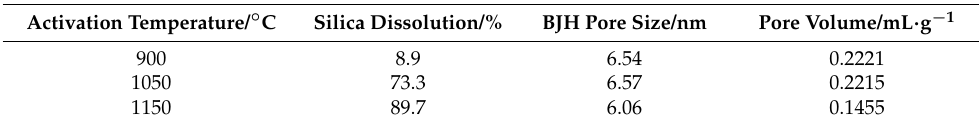
Figure 6. BJH pore size distributions of porous alumina. (Porous alumina prepared via alkali leaching of kaolinite activated at ( a ) 1150 °C; ( b ) 1050 °C and ( c ) 900 °C, for 15 min. Table 2. Correlation between the pore features of porous alumina and silica dissolution of activated kaolinite.